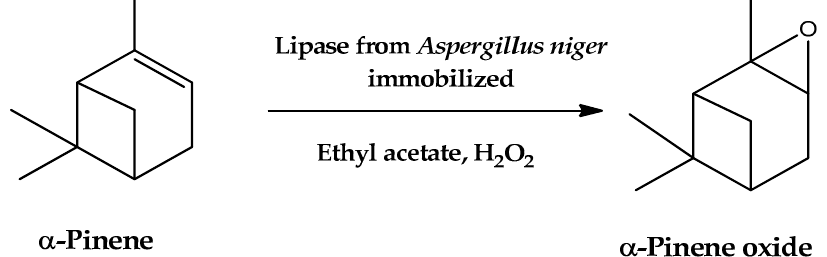
Figure 18. Chemo-enzymatic epoxidation of α -pinene catalyzed by the lipase from Aspergillus niger immobilized in calcium alginate beads. immobilized in calcium alginate